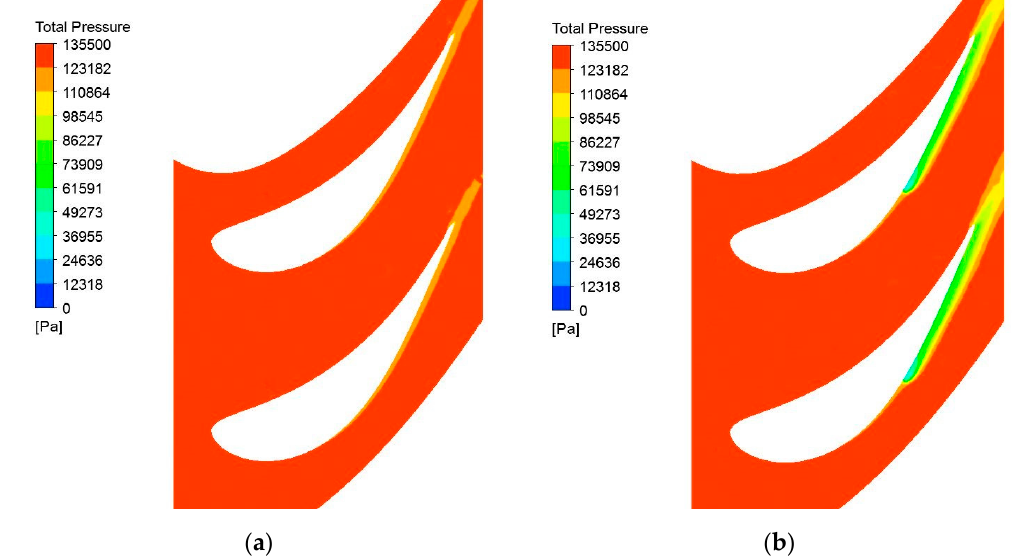
Figure 6. ( a ) Total pressure distribution at mean radius without injection; ( b ) Total pressure distribution at mean radius after the injection process.